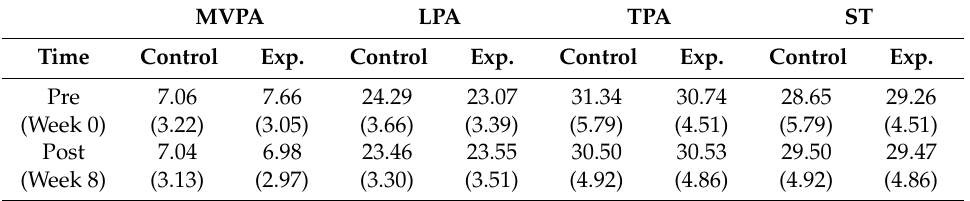
Table 2. Mean (SD) in minutes / hour of preschoolers’ physical activity and sedentary time. MVPA LPA TPA ST Time Control Exp. Control Exp. Control